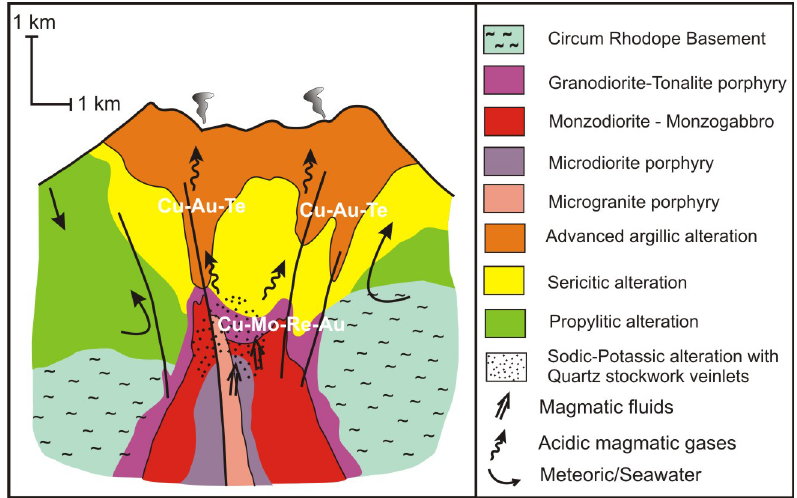
Figure 9. Schematic diagram integrates magma emplacement, degassing and porphyry-epithermal mineralizing processes in northeastern Greece. Four successive magmatic pulses (granodiorite–tonalite porphyry, monzodiorite–monzogabbro, microdiorite and microgranite porphyry) within metamorphic basement and coeval volcanic rocks resulted in superimposed porphyry-epithermal style of mineralization and upgrading of earlier formed mineralization. Magmatic vapors resulted in the formation of high-sulfidation Cu–Au–Te mineralization within advanced argillic alteration lithocaps and fluid inclusion evidence suggests that rheniite, Re-rich molybdenite, chalcopyrite and native gold at Pagoni Rachi and Konos prospects may have precipitated as temperatures fell below 400 °C during phase separation at relatively oxidized conditions, high chlorine activity, and from relatively acid hydrothermal